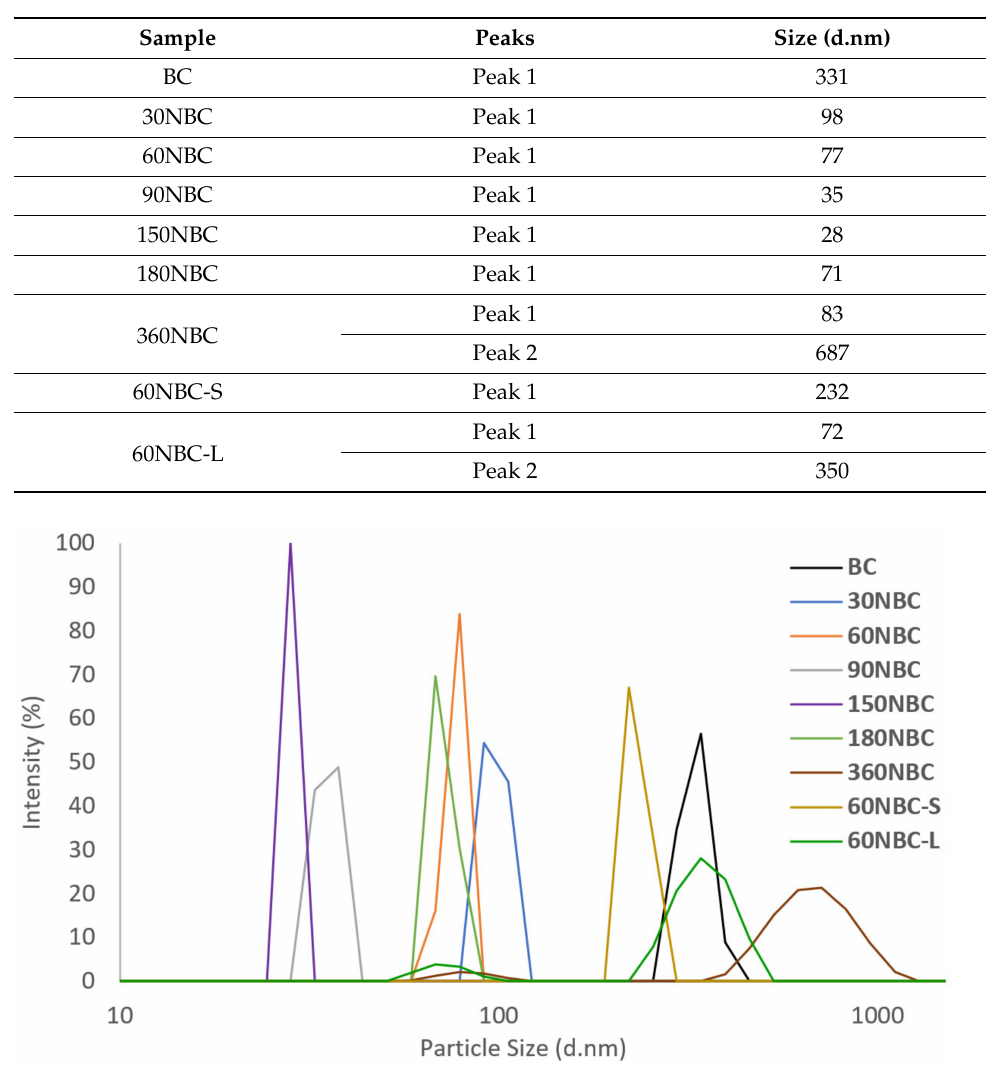
Figure 3. The particle size distribution of the biochar and NBC based on